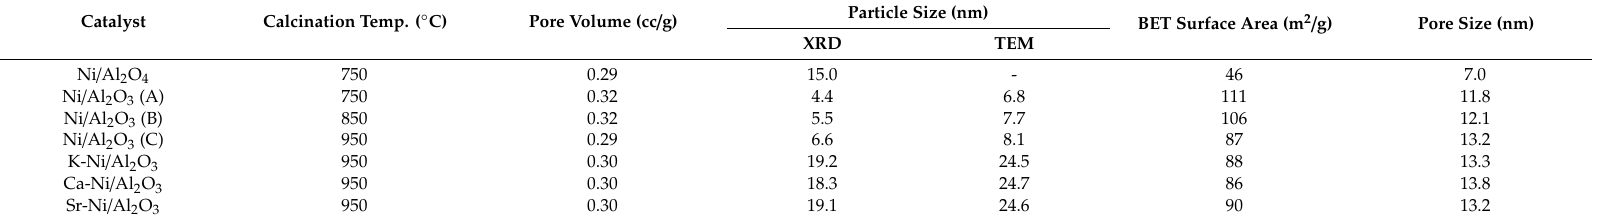
Table 4. The physicochemical properties of alkali promoted Ni-based catalysts [83] (used with copyright permission).